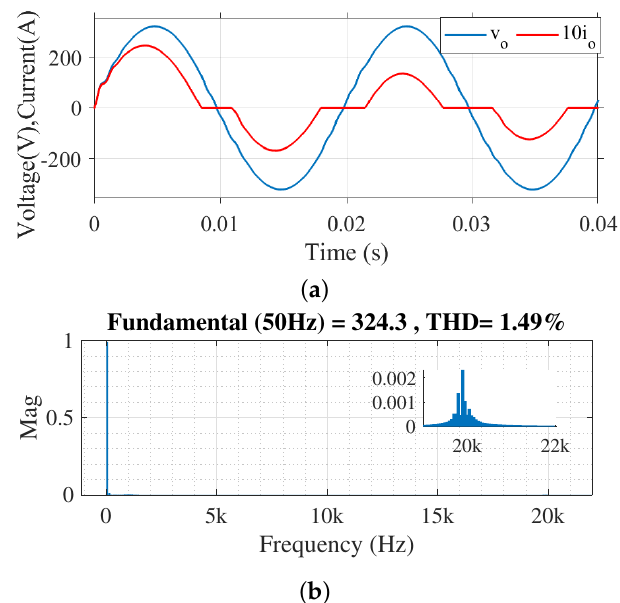
Figure 18. Simulation results of the system while feeding a nonlinear load. ( a ) Output voltage and current waveforms. ( b ) Harmonic spectrum of output